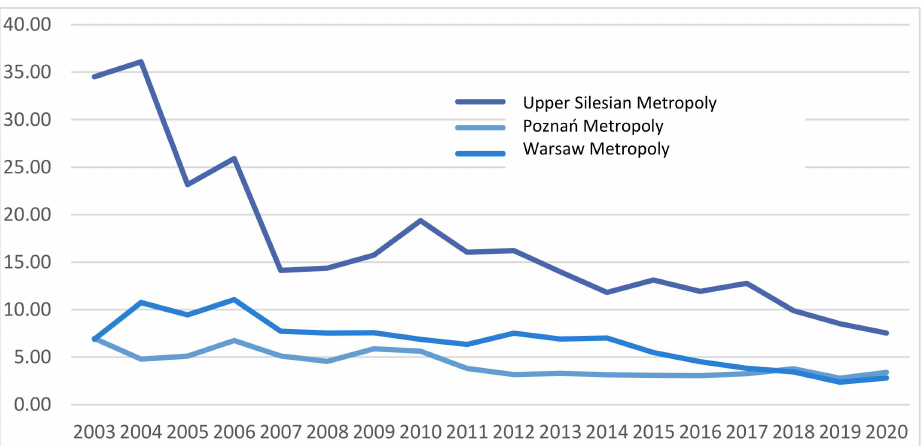
Figure 6. The results of SO 2 measurements in three metropolises in Poland in the period from 2003 to 2020. Source: Own elaboration based on measurements